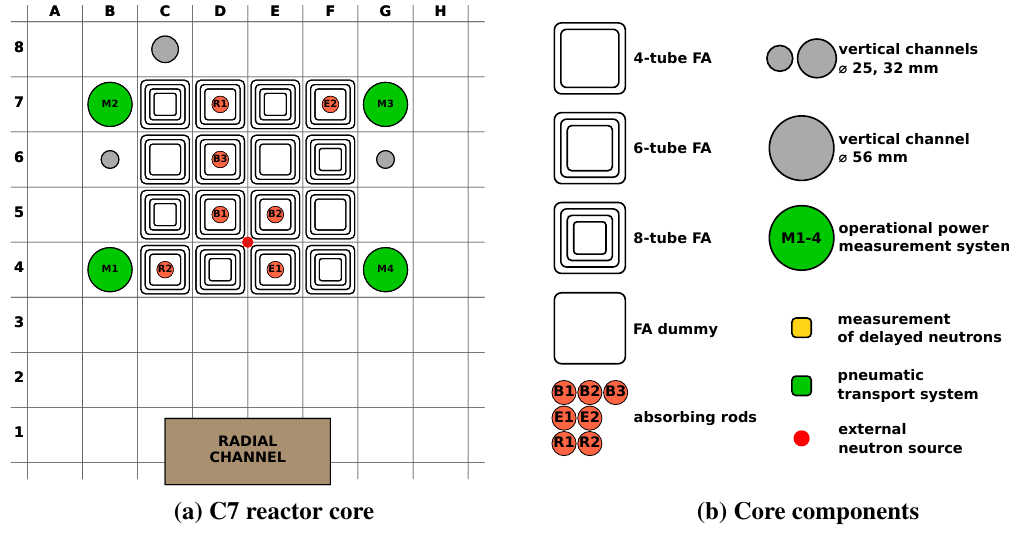
Figure 1: One of the evaluated VR-1 reactor